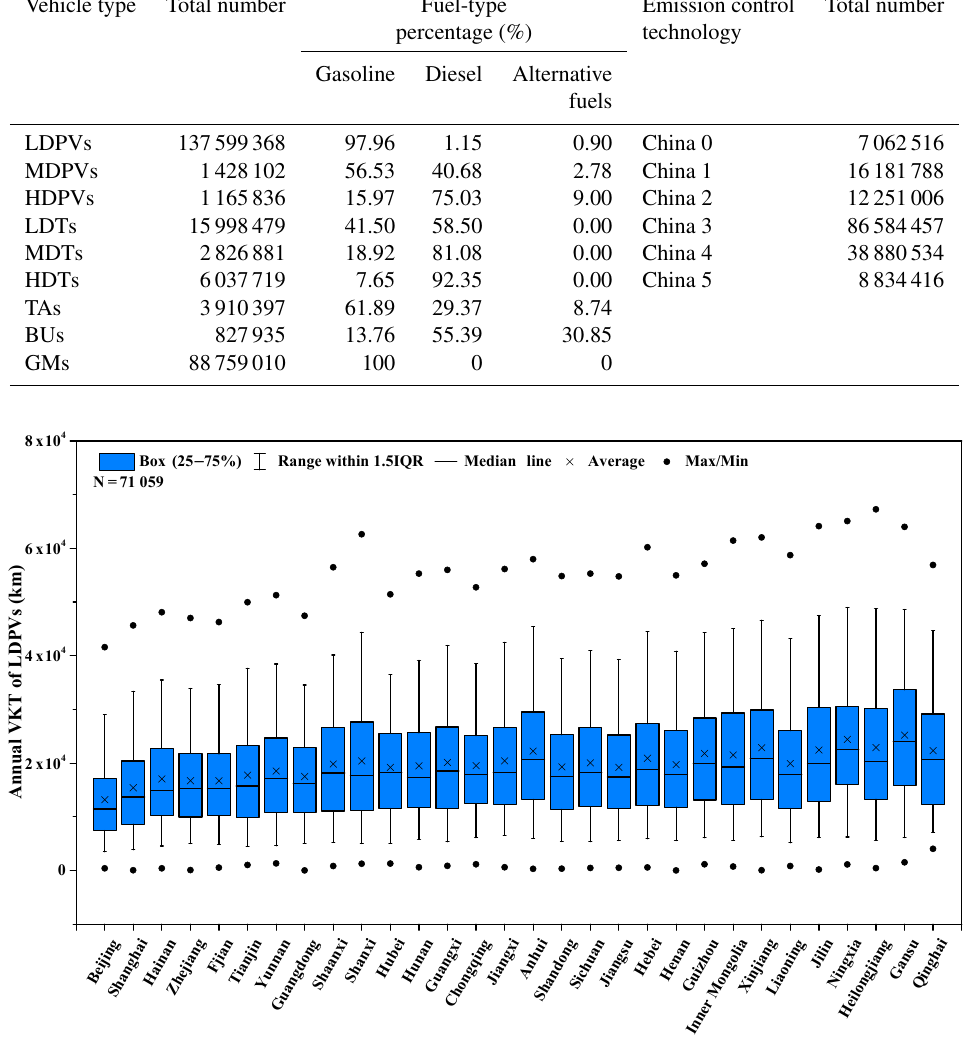
Figure 2. Provincial annual VKT of LDPVs in